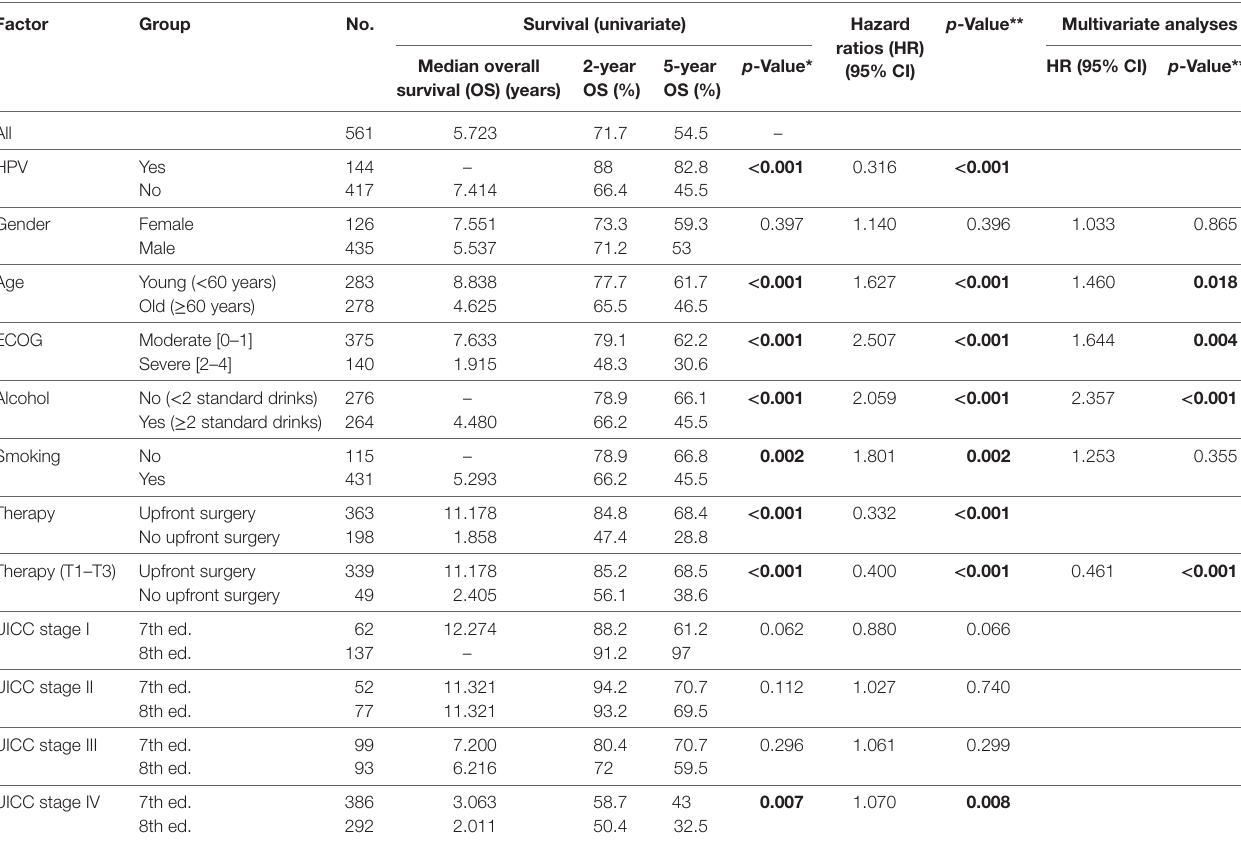
taBLe 3 | Prognostic factors for survival in patients with oropharyngeal cancer after curative therapy and with known human papilloma virus (HPV) status.